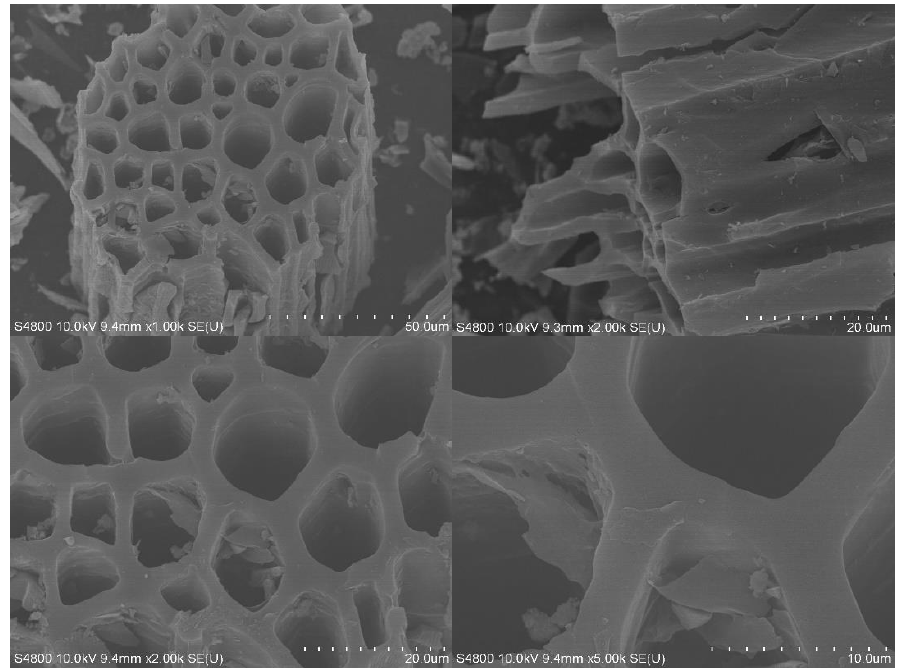
Figure 1. SEM images of SF−HPC .